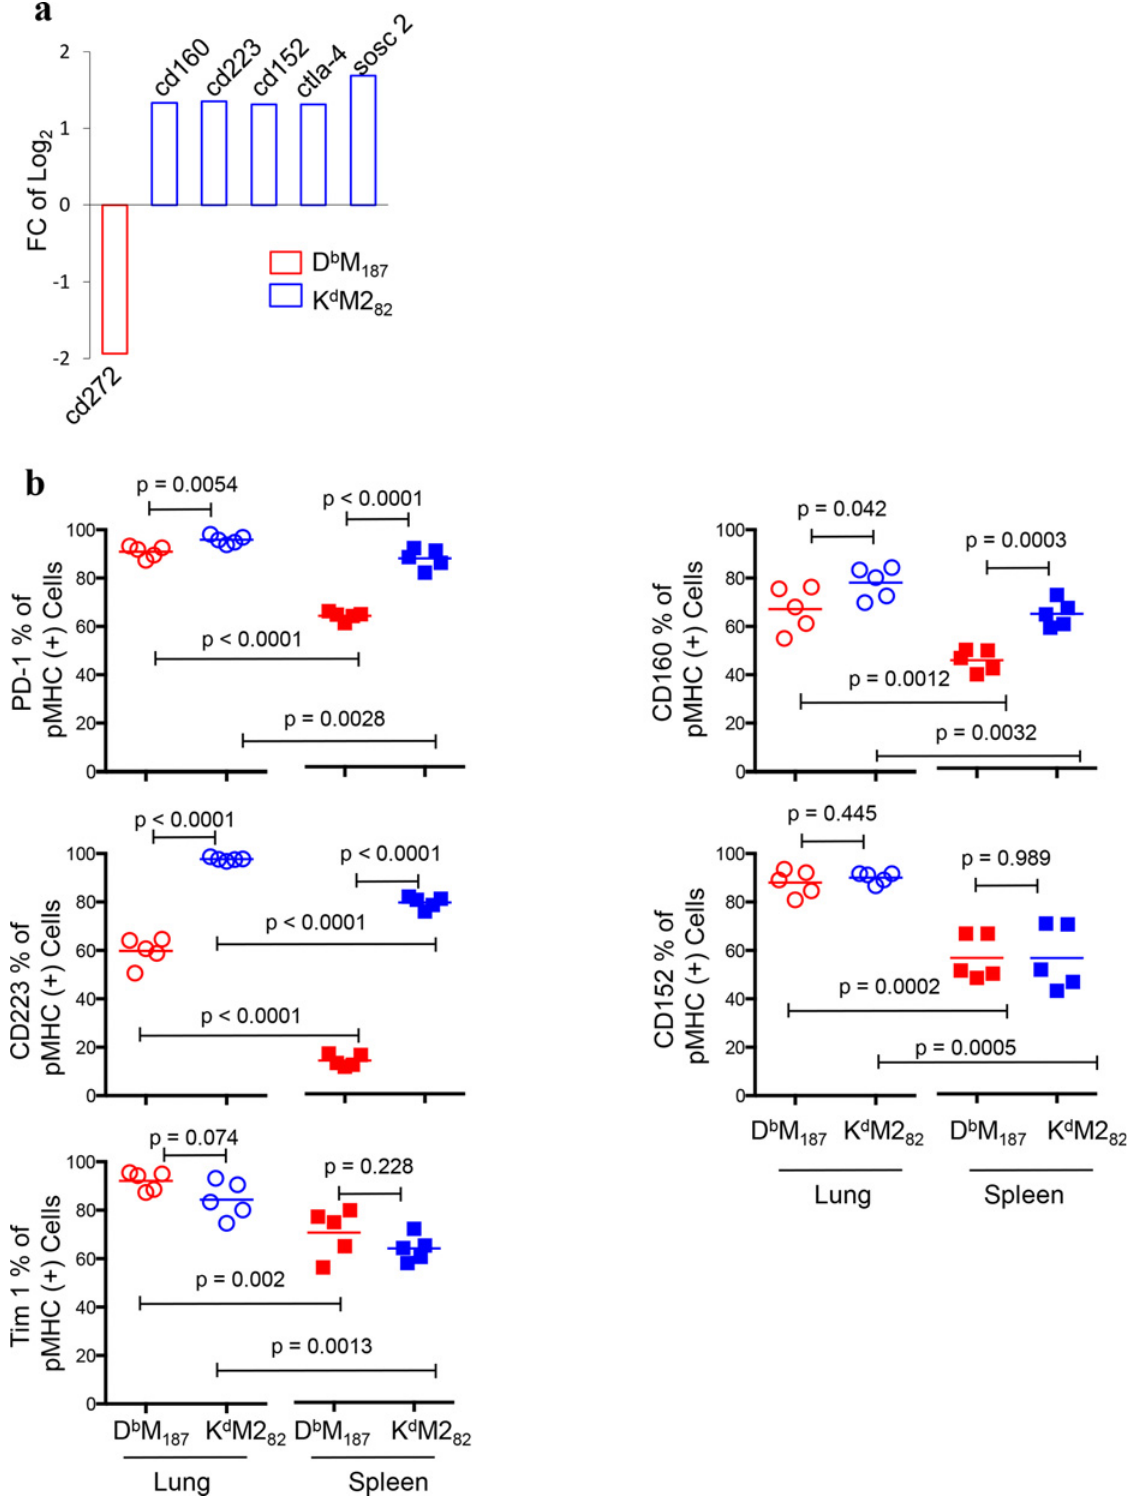
Fig 5. Activated K d M2 82 T cells up-regulate expression of inhibitory receptors. (a) Transcriptional expression of genes encoding inhibitory receptors with FC > ± 1.3, p < 0.05 and FDR < 0.25 were listed. Data were pooled from 10 or 11 individual mice in each group. ( b ) Post-transcriptional expression of inhibitory receptors at 7 dpi was assessed by flow cytometry. The frequencies are shown as mean with independent data point and compared by Student ’ s t - test. Data represent 5 independent experiments (n = 5/group/experiment). Each symbol represents one mouse. doi:10.1371/journal.ppat.1005486.g005 PLOS Pathogens | DOI:10.1371/journal.ppat.1005486 March 4,